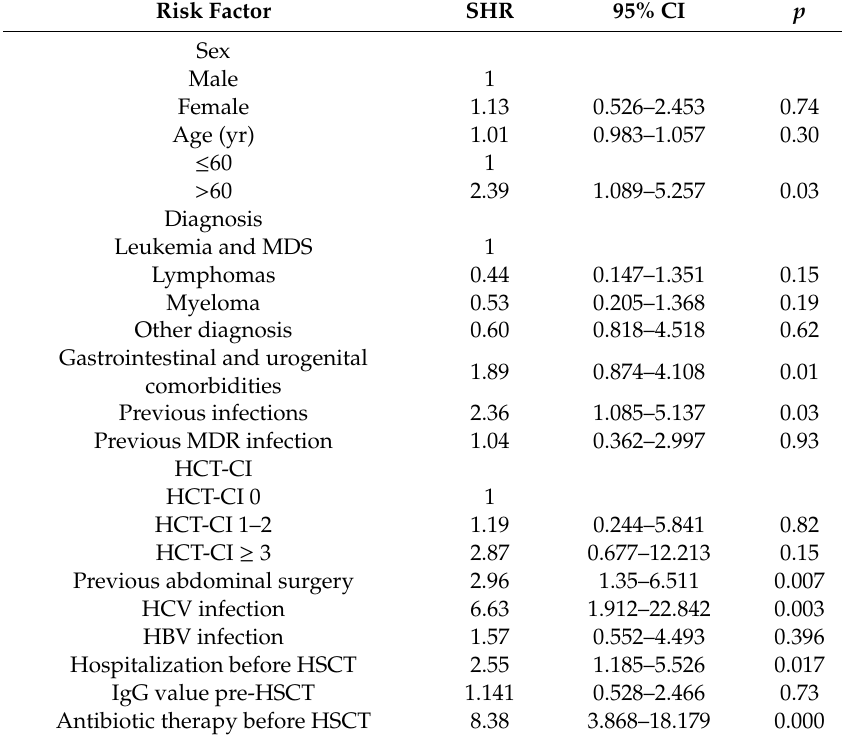
Table 4. Univariate analysis of risk factors for incidence of